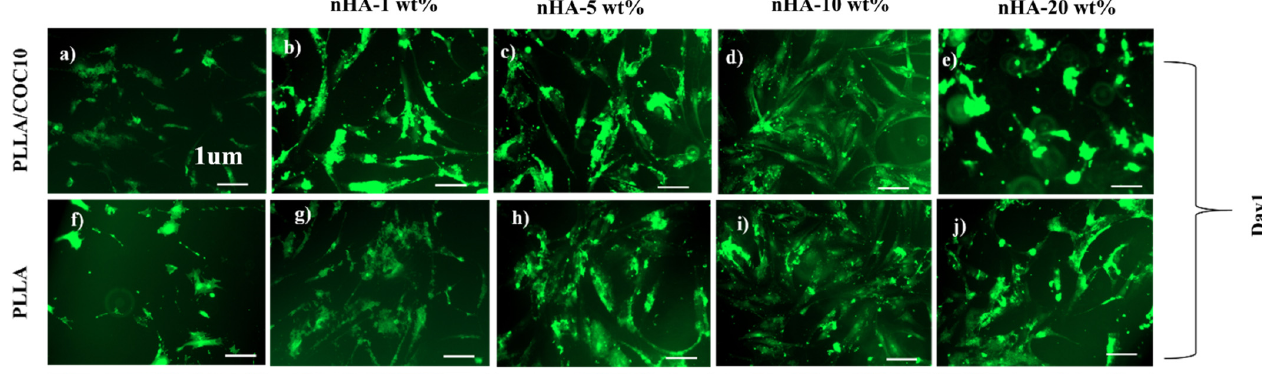
Figure 9. LIVE/DEAD assay BMSC grown on PLLA/COC10-nHA and PLLA/nHA at various times were tested. The scale bar is 1 μ m in all the images. Nanocomposites had nHA in 1 wt%, 5 wt%, 10 wt%, and 20 wt%. PLLA/COC10-nHA on day 1 ( a − j ) represented cell adhesion better than PLLA/nHA. Day 14 ( a − j ) cells were proliferating, whereas multilayer cells were proliferating at an accelerated rate on day 21 ( a − j ). F-actin and DAPI staining were used to examine cell morphologies in addition to cell proliferation as illustrated in Figures 10 and 11. The PrestoBlue analysis was supported by F-actin and DAPI image analysis with the passage of time [64]. In comparison to pure PLLA or PLLA/nHA, PLLA/COC10-nHA blends demonstrated a higher number of cells. In PLLA/COC10-nHA at 5 wt%, nHA cell density grew by 1.5 times, while at 10 wt%, cell densities rose three-fold. The number of DAPI positive cells per fixed area was used to compute the cell density. Furthermore, when